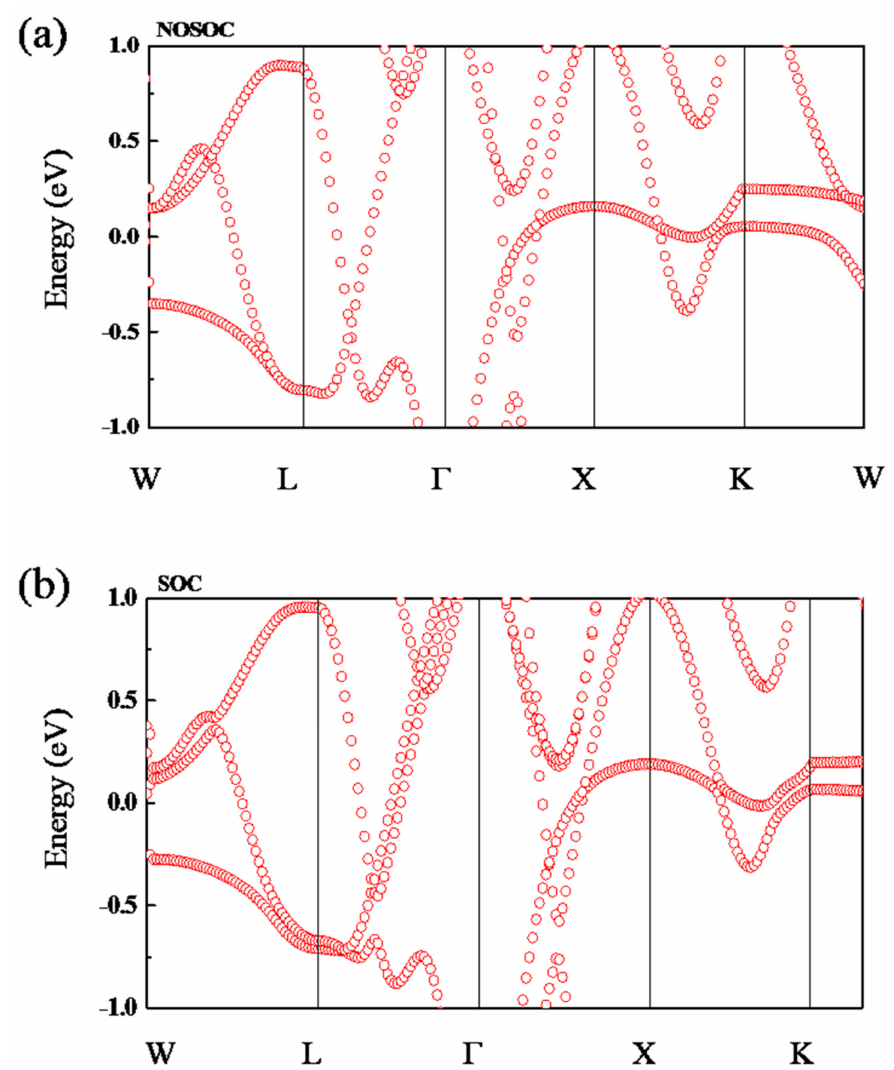
Figure 5. ( a ) The band structure of Sn 2 CoS without SOC by the modified Becke − Johnson (MBJ) po- tential. ( b ) The band structure of Sn 2 CoS with SOC by the modified Becke − Johnson (MBJ)